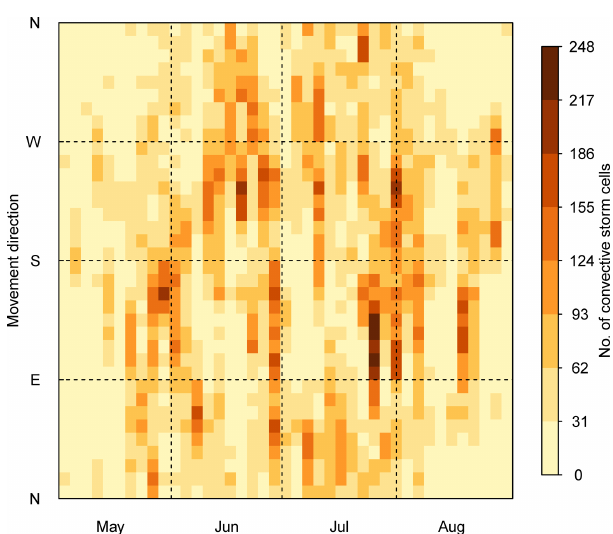
Figure 9. The 2-D histogram of the number of convective storm cells as a function of month and movement direction, for the Prut River basin, between 2003 and 2017